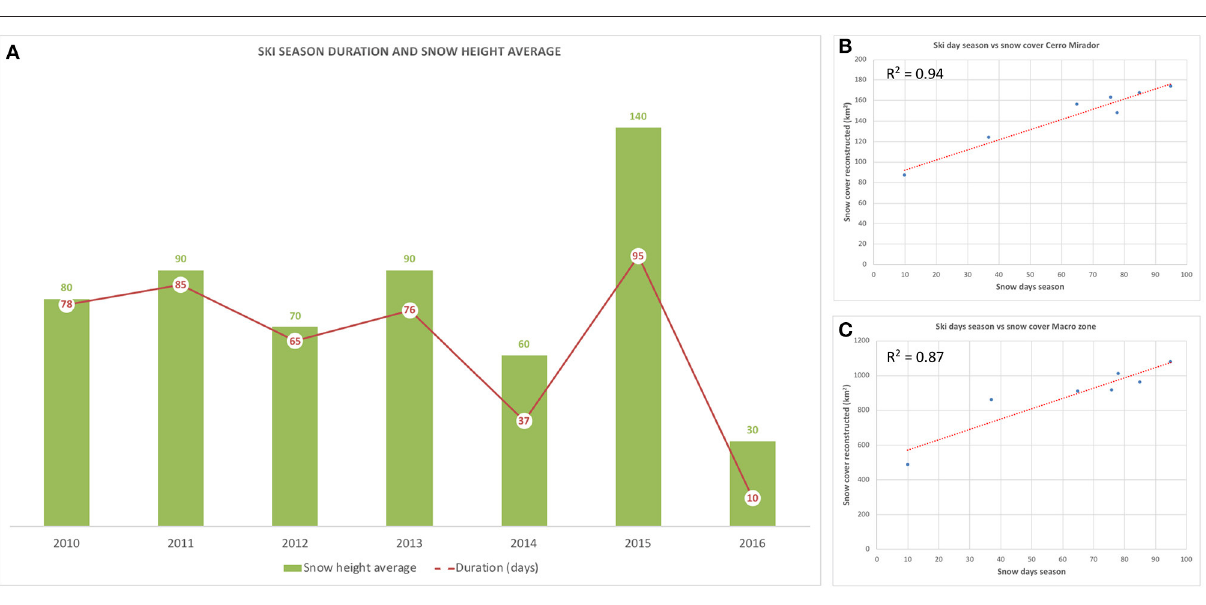
PDO result in lower (higher) snow cover in the Brunswick Peninsula. Individual year-to-year variability given by El Niño and La Niña phases does not show a direct relation with